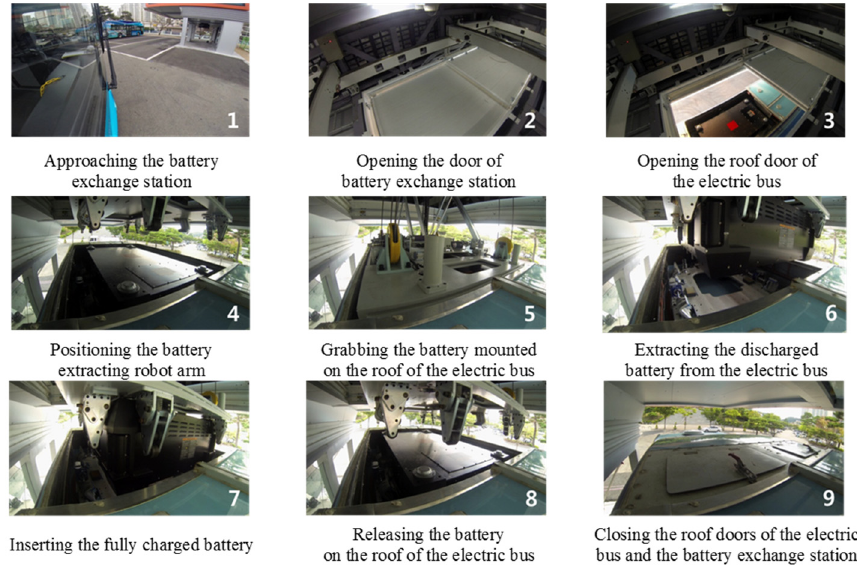
Figure 1. Illustration of the battery exchange process.